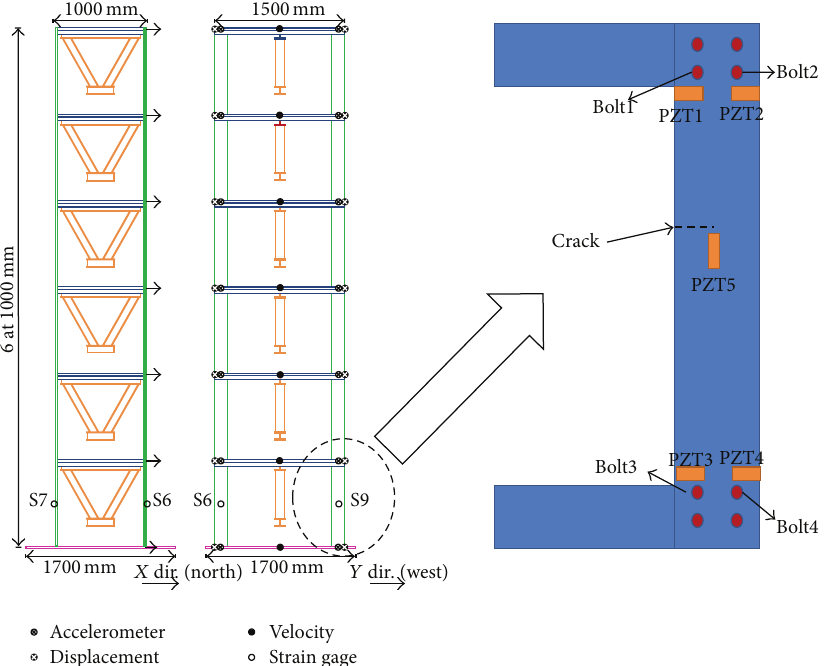
Figure 14: Experimental setup of the test structure.